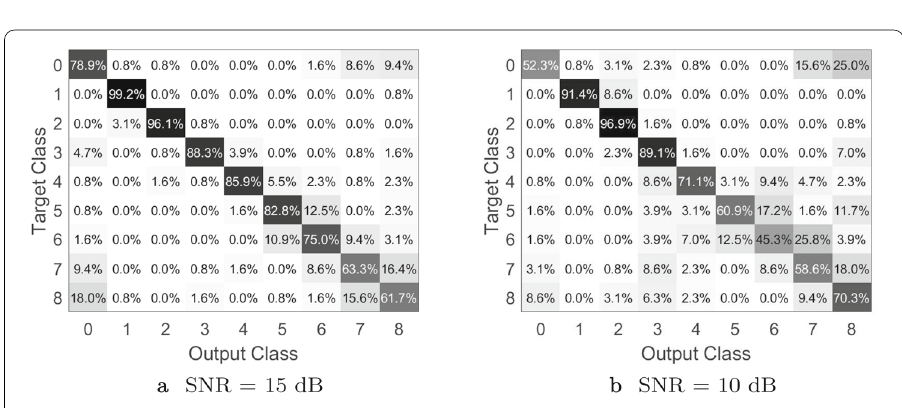
Fig. 16 Damage localization, case 1. Confusion matrices, case 1, 15 dB (left picture) and 10 dB (right picture) SNR datasets